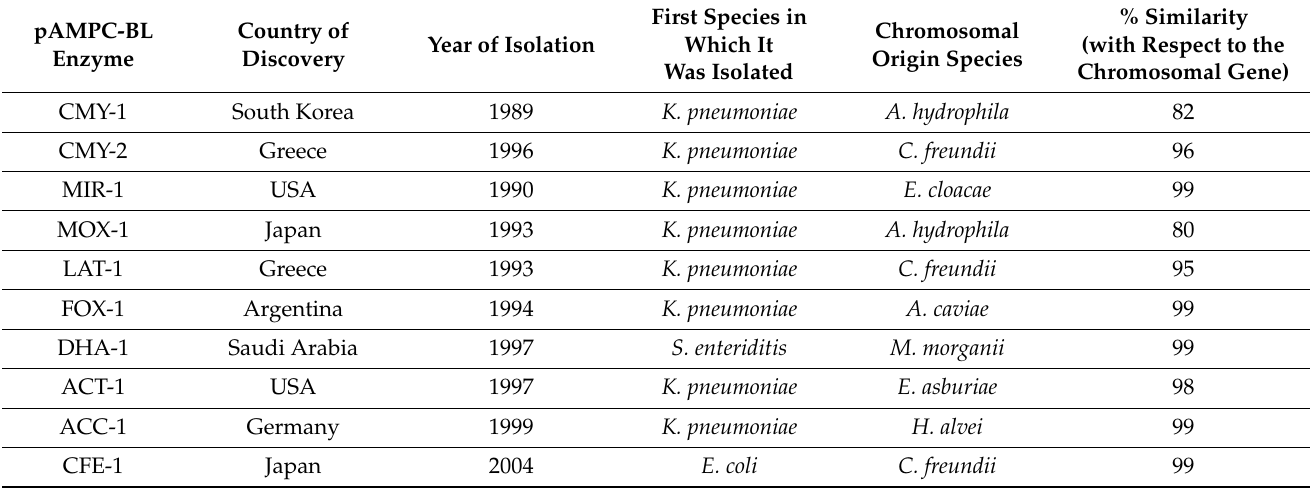
Table 1. Isolation of the first pAmpC-BLs (modified by Jacoby, 2009)